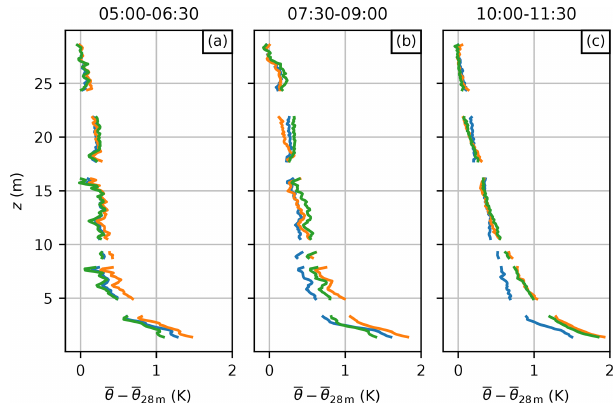
Figure 13. Observed temperature profiles for 21–23 April 2020 dur- ing three different averaging windows: (a) before the sea-breeze front has passed, (b) after the front has passed on 22 April but not on 23 April, and (c) after the front has passed the site on 22 and 23 April. The corresponding averaging intervals are given at the top of each